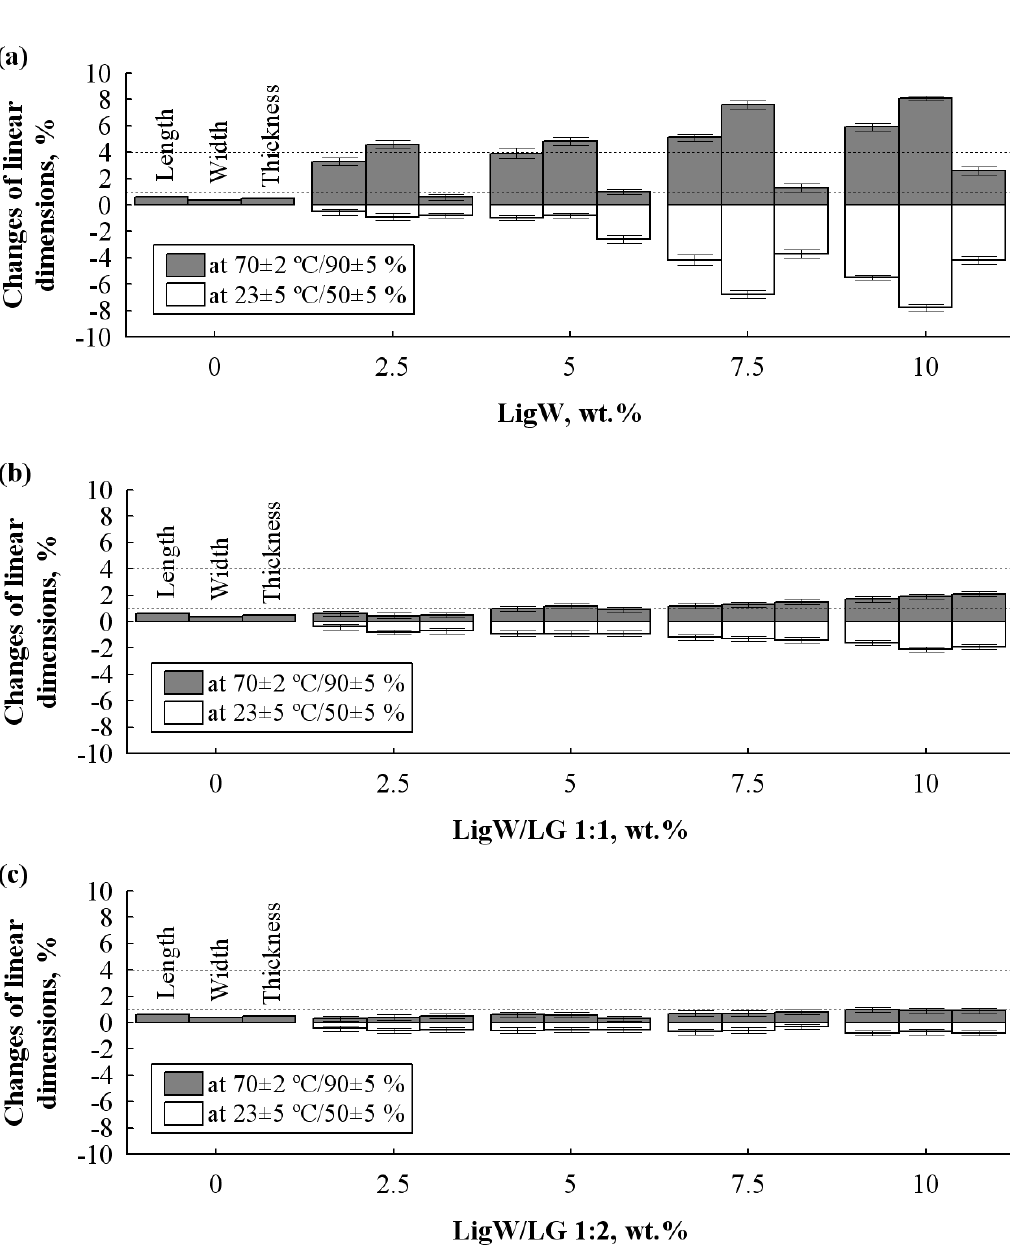
Figure 5. Dimensional stability of bioPUR foams at normal and elevated conditions: ( a ) with LigW particles; ( b ) with LigW/LG 1:1 particles; ( c ) with LigW/LG 1:2 particles. (-----)—the strictest requirements of length, width (≤ 4%) and thickness (≤ 1%) at elevated temperature and humidity conditions according to EN 14315-1 [17].